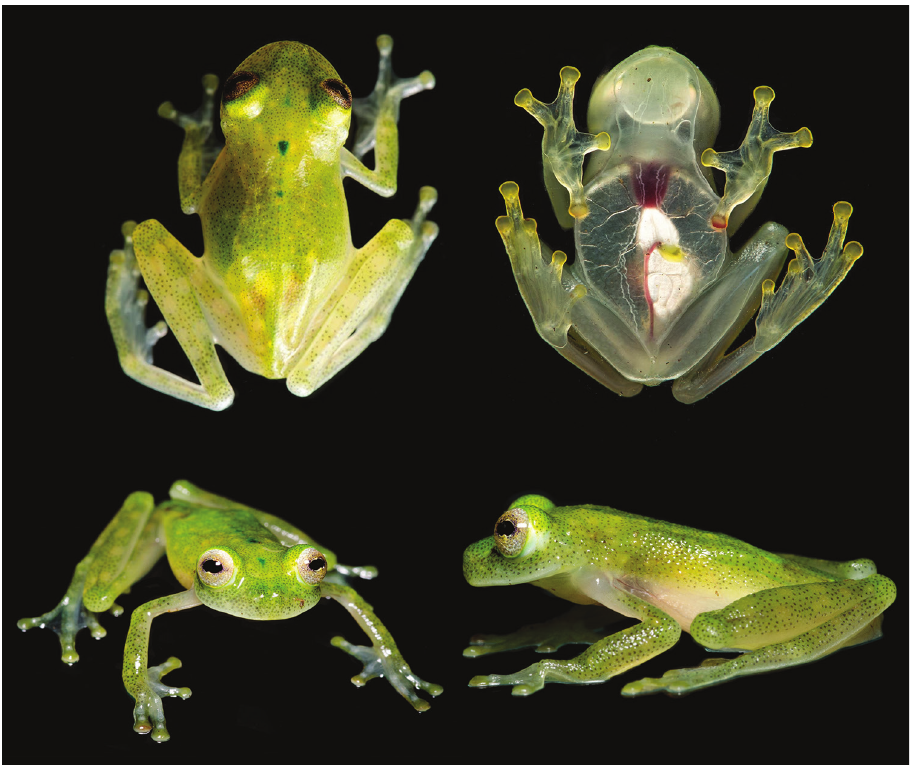
Figure 1. Hyalinobatrachium yaku sp. n. in life. Top row: adult male, MZUTI 5001, holotype, in dorsal and ventral view. Bottom row: adult male, paratype, QCAZ